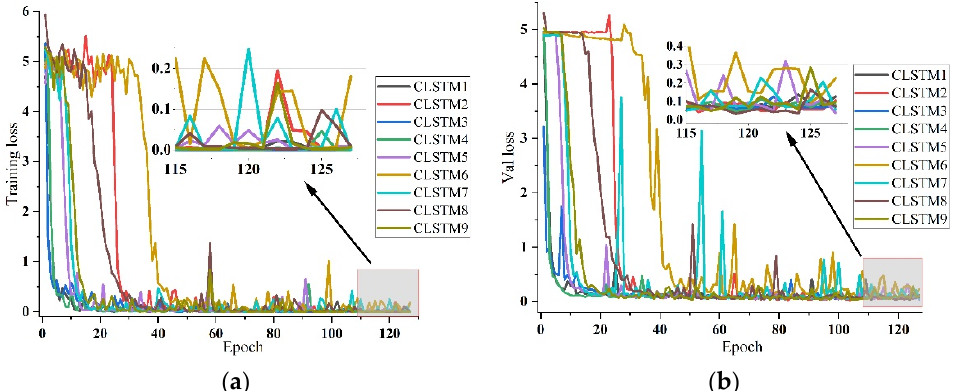
Figure 11. Training and validation losses for CLSTM models with nine different network structures: ( a ) training loss values for the nine models; ( b ) validation loss values for the nine models.